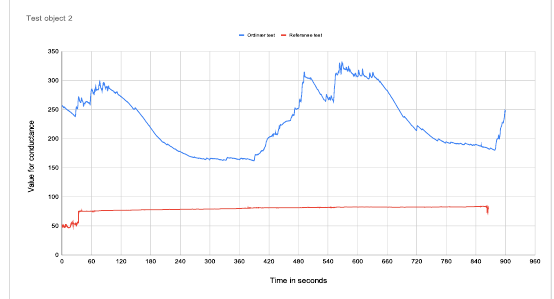
Figure 8: Plot of conductance for test subject 3 Percentage change with electrodes in palm: 51,16% Percentage change with electrodes on arm: 44,61%